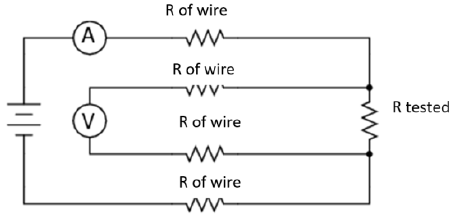
Figure 2. The equivalent circuit of electrical connections in the method used for measuring the surface resistance of textiles.